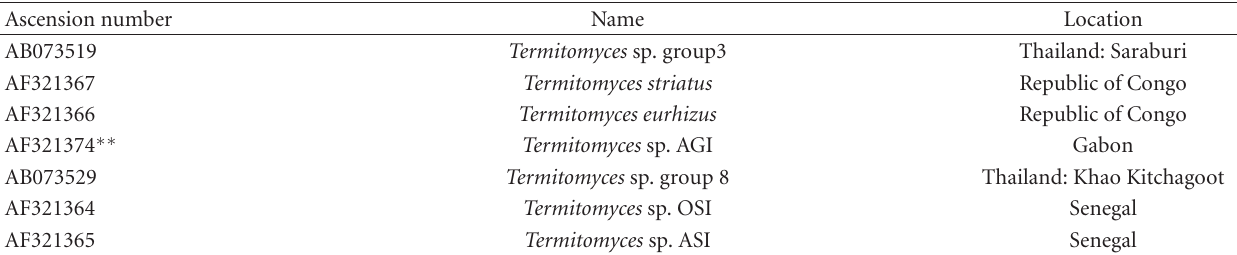
Table 3: Information on gene sequence of Termitomyces species from NCBI GenBank with close identity with T 1 to T 18 . Ascension